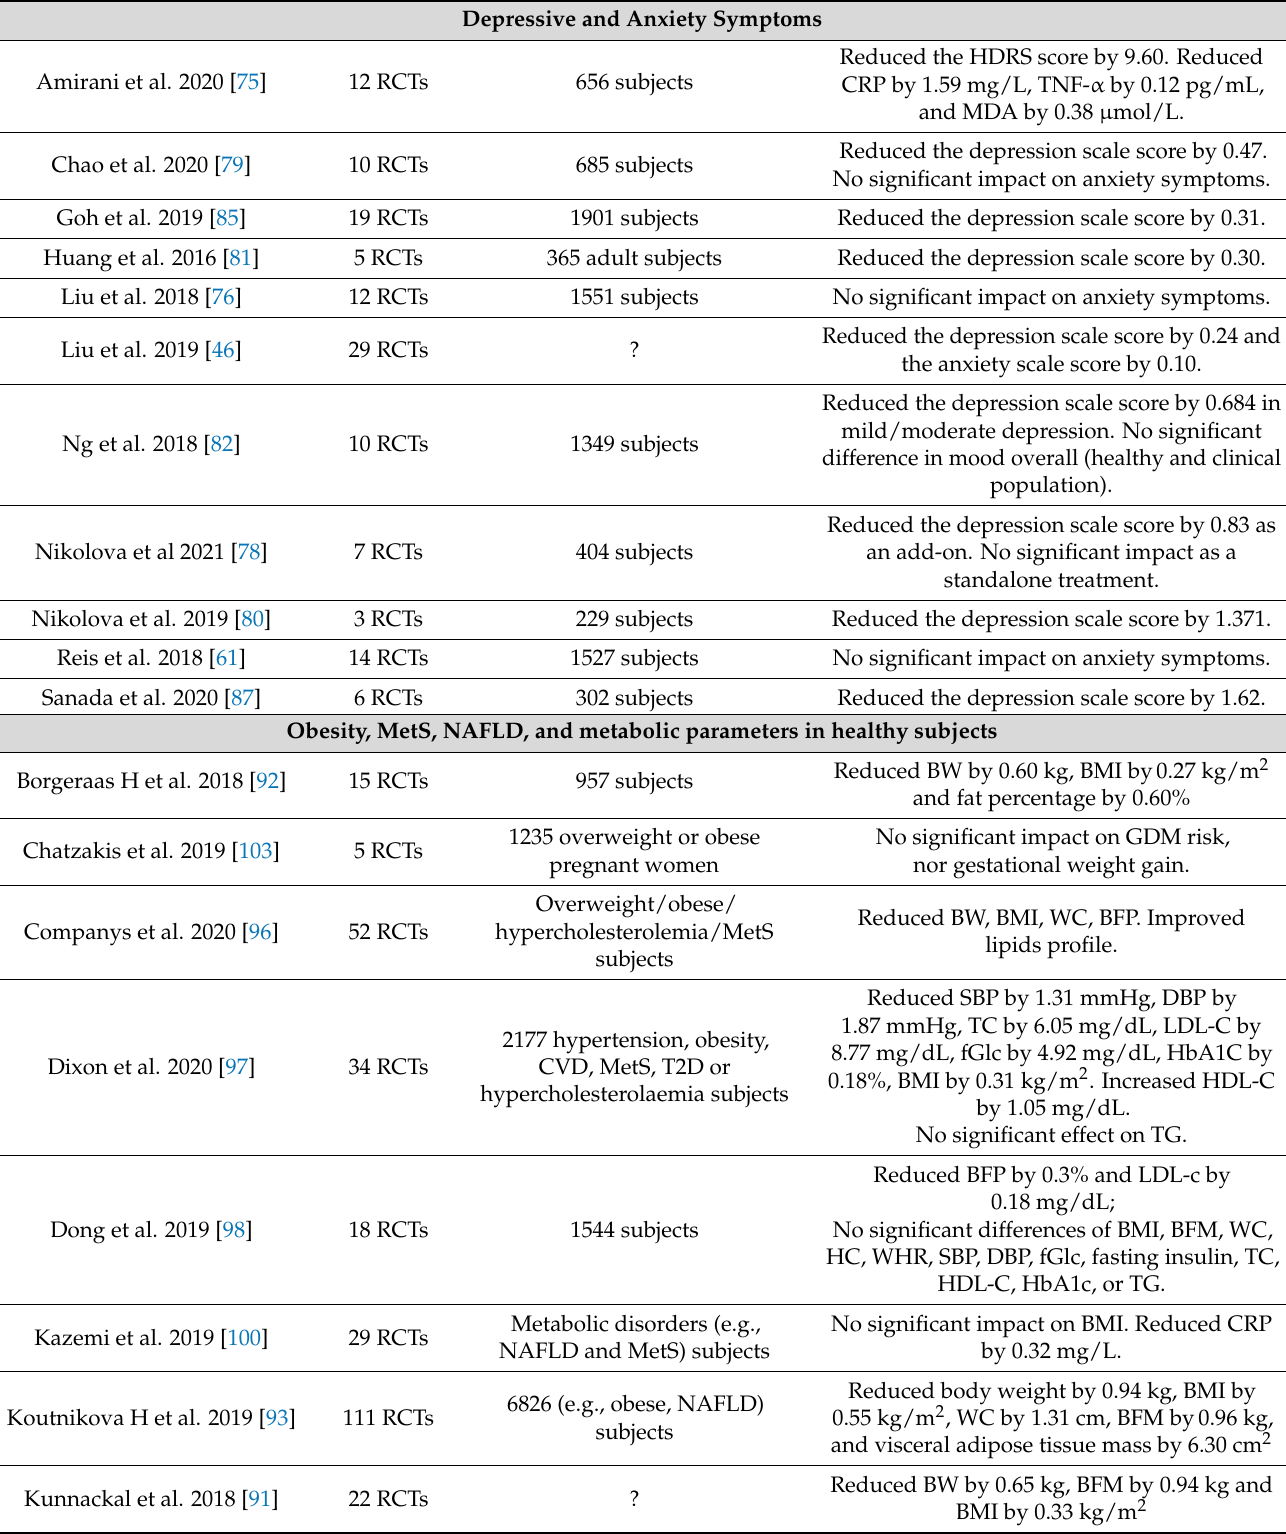
Table 2. Meta-analyses of RCTs with probiotics efficacy towards depressive and anxiety symptoms and recent meta-analyses of RCTs with probiotics efficacy toward metabolic health